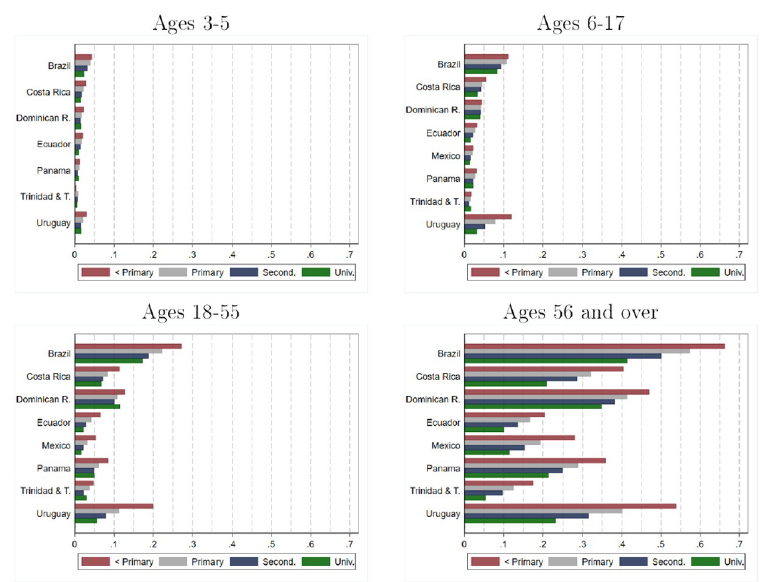
Fig 5. Prevalence of disability: Estimates by age, country and household head education level. Source: authors’ estimations based on data provided by [10] from censuses collected by National Statistics Offices in each country. Estimates for Brazil, Dominican Republic, Ecuador, Mexico, and Panama refer to the year 2010. Estimates for Costa Rica, Trinidad and Tobago, and Uruguay refer to the year